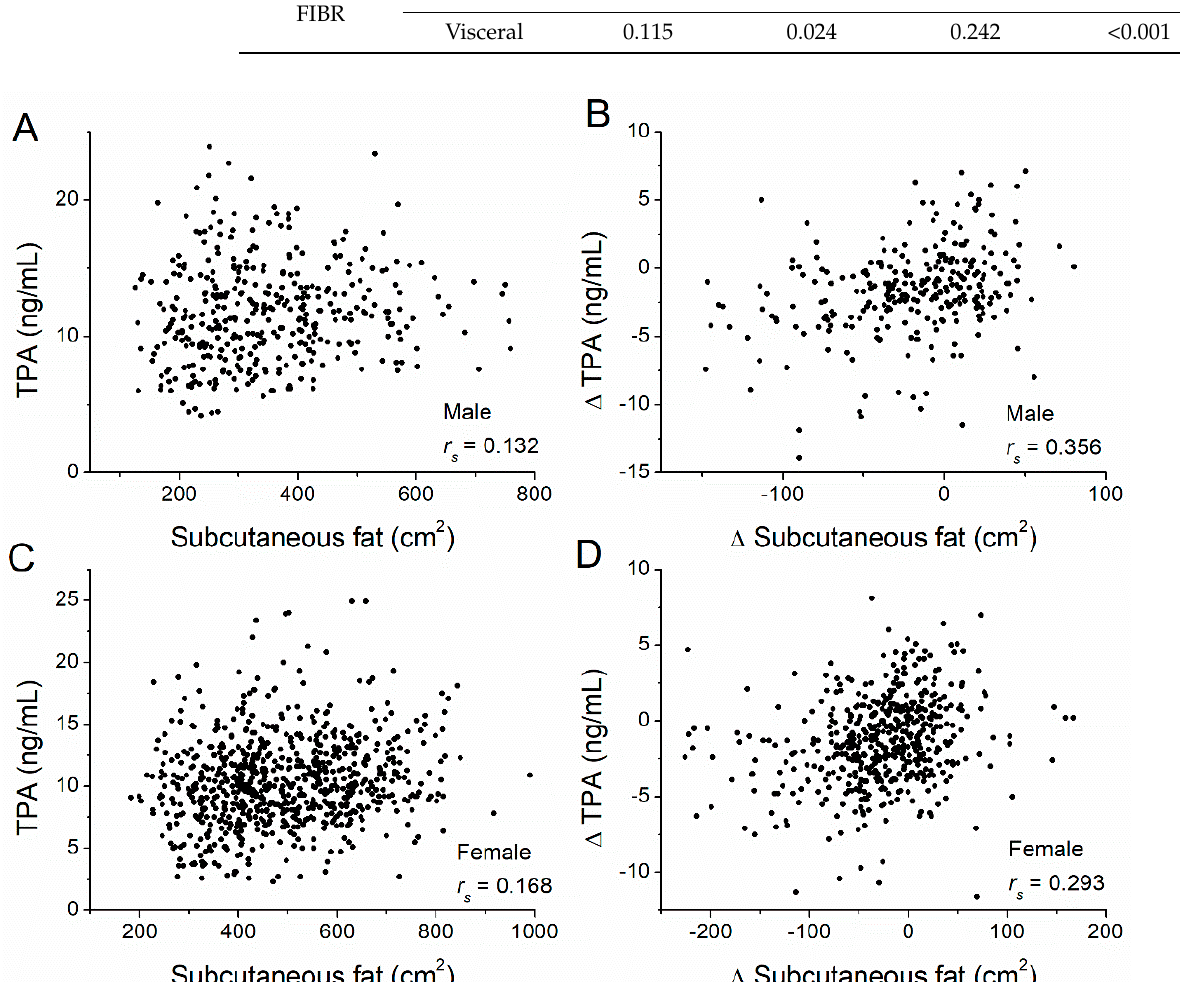
Figure 2. Correlations between subcutaneous adipose tissue (SAT) volume and TPA levels, and between their changes. Correlations between ( A ) SAT and the TPA level ( r s = 0.132, p = 0.009), and between ( B ) changes in SAT and changes in TPA levels ( r s = 0.356, p < 0.001) in male participants of the diabetes prevention program. Correlations between ( C ) SAT and the TPA level ( r s = 0.168, p < 0.001), and between ( D ) changes in SAT and changes in TPA levels ( r s = 0.293, p < 0.001) in female participants. Adipose tissue volume was measured at baseline and the one-year follow-up by computed tomography at the L4–L5 level. Δ = value (year 1) − value (baseline) , where values correspond to fat volume or TPA. The Spearman’s rank correlation coefficient, r s , was calculated. Table 3. Correlation between changes in size of different fat depots and changes in levels of TPA and FIBR.